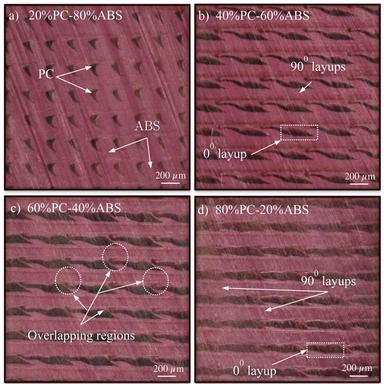
Microstructural images of PC/ABS FGMs with different volume concentrations.